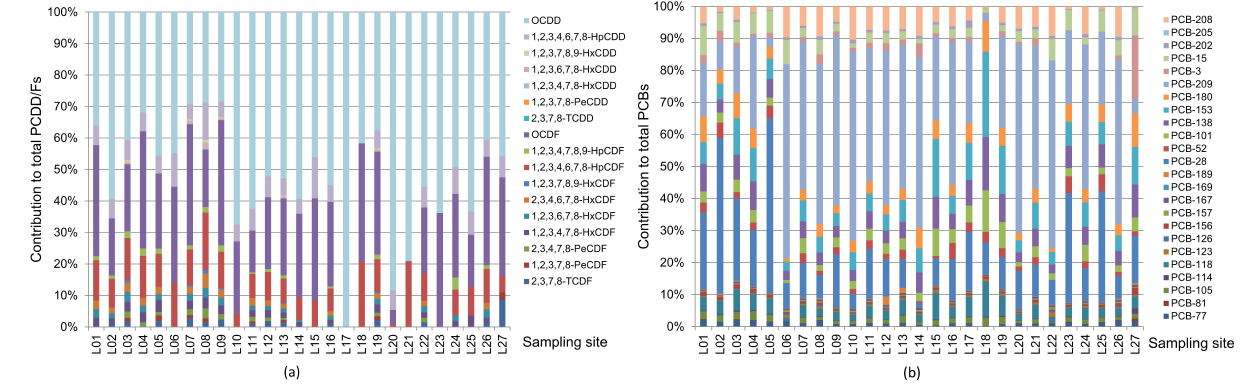
Figure 3. Percentage composition of PCDD/F ( a ) and PCB ( b ) congeners in the sediments from